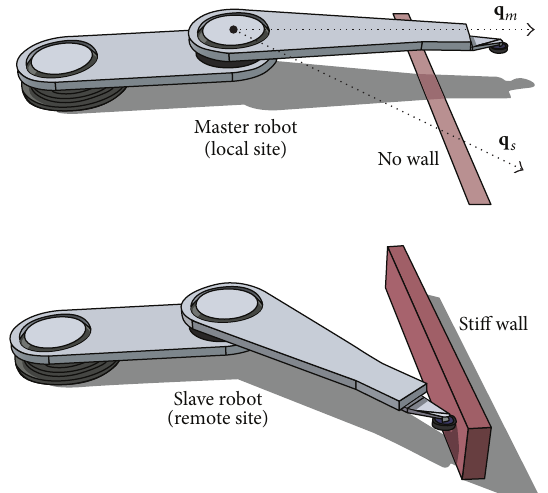
Figure 1: Example of a master-slave teleoperation system. If the transmitted impedance to the human operator is not sufficiently large, the operator will feel a softer remote environment and may still continue the motion of the master robot despite the slave robot’s position being locked by the